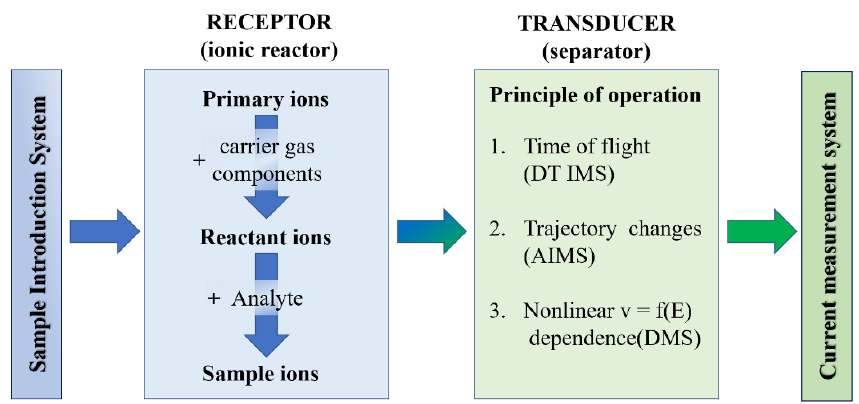
Figure 6. Ion mobility spectrometry (IMS)—operation principle and elements of measurement systems.